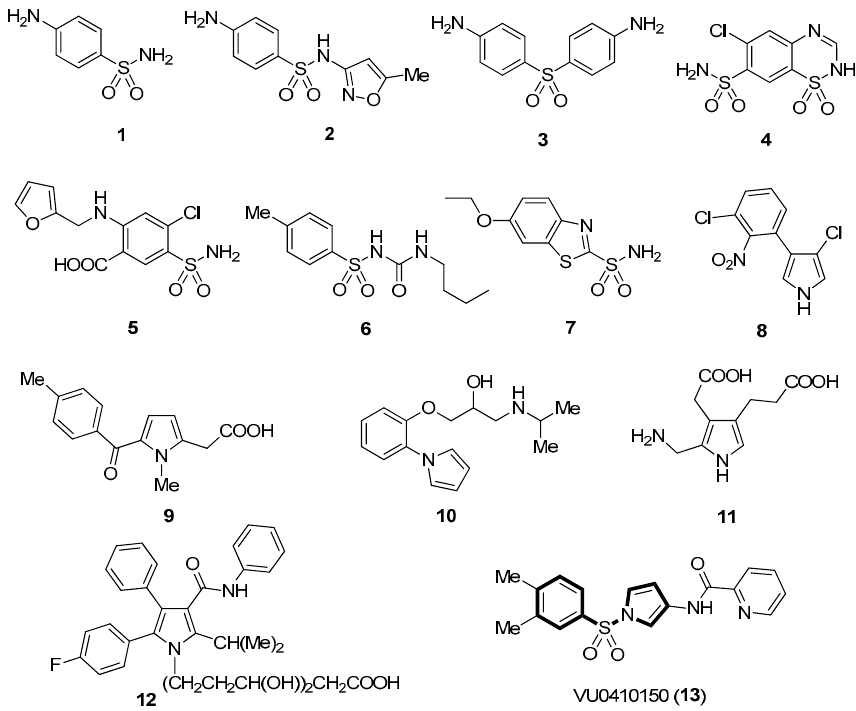
Chart 1. Examples of sulfa and pyrrole containing drugs.